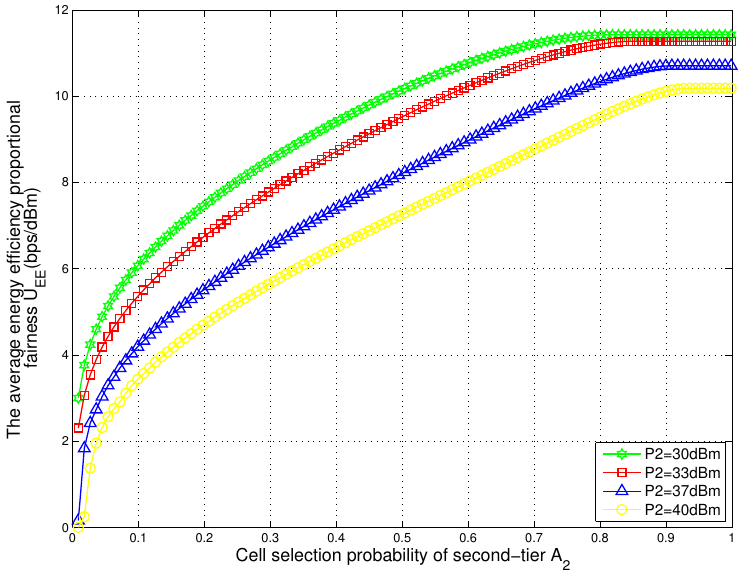
Figure 6. The energy efficiency proportional fairness of total two-tier heterogeneous WPCNs with respect to the association probability of tier 2 for different values of the transmit power of